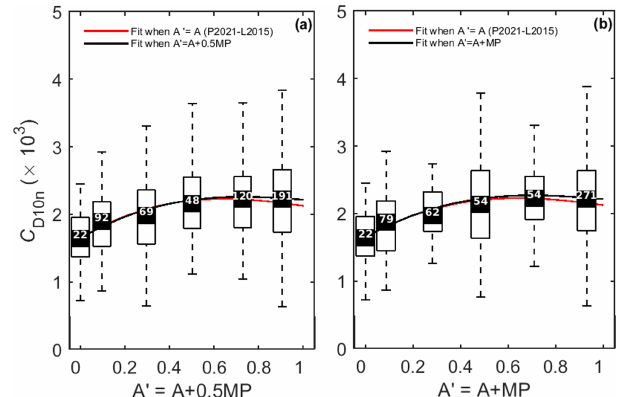
Figure B1. Parameterization sensitivity to the melt-pond (MP) fraction. Panel (a) re-classifies half of melt ponds to sea ice (A’ = A + 0.5 · MP), whereas (b) re-classifies all of the melt points to sea ice (A’ = A + MP), where A is the sea-ice fraction. The curves show the L2015 parameterization, tuned to the original ice fraction observations (red; P2021–L2015) and tuned to the adjusted ice fraction observations (black).